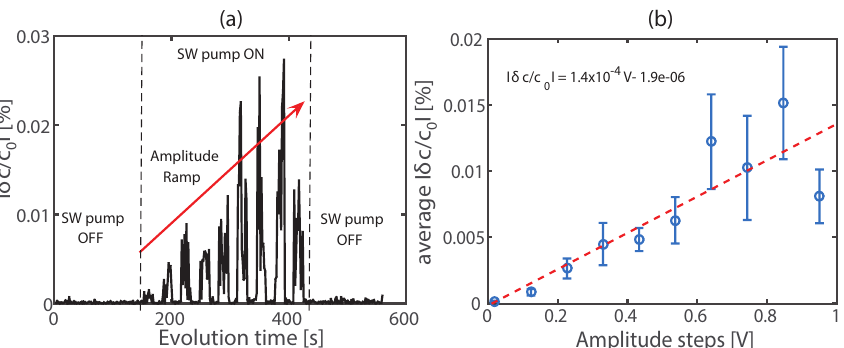
Figure 6. NCWI results for preliminary study. ( a ) Relative sound speed variation from CWI signal processing application. ( b ) Average sound speed variation δ c / c 0 as a function of the SW pump-wave amplitude and estimation of the nonlinear elastic hysteretic parameter α .